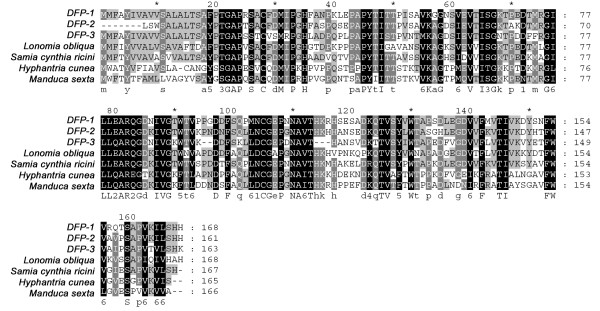
Multiple sequence alignment of DFP-1, 2 and 3 amino acid sequences with homologues from other lepidopterans. Lonomia obliqua [GenBank:AAV91350], Manduca sexta [GenBank:AAO21507], Samia cynthia ricini [GenBank:BAD05929], Hyphantria cunea [GenBank:AAD09280] protein sequences, respectively. Black and grey shades indicate the identical and similar amino acid residues, respectively.